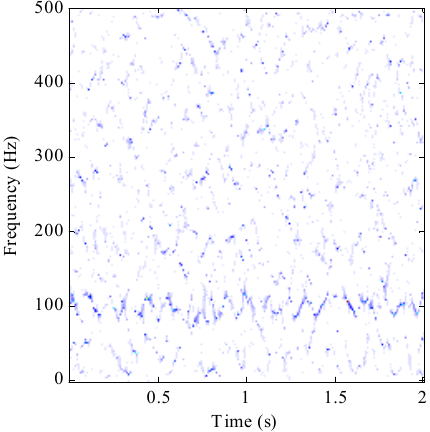
Figure 4. SST method result for simulation signal with − 5 dB noise.